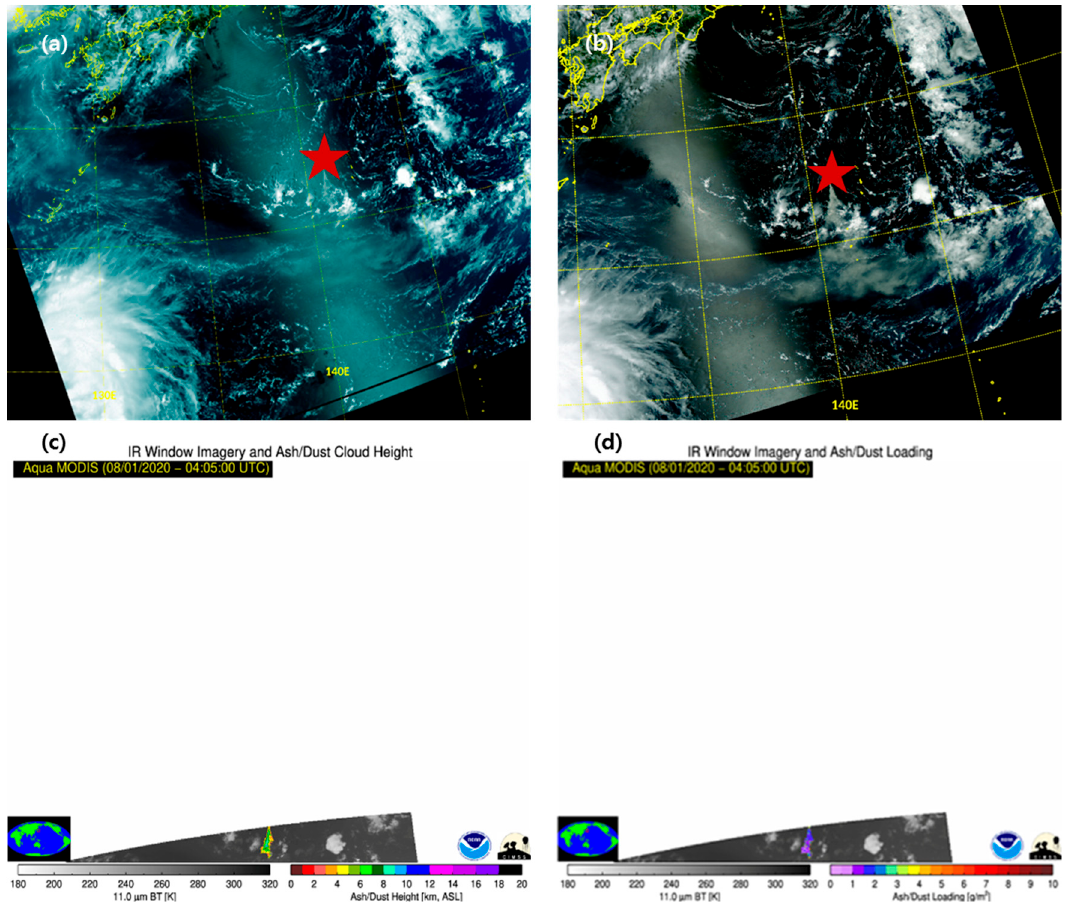
Figure 7. Images of low Earth orbit (LEO) satellites in the Nishinoshima area obtained on 1 August 2020. ( a ) Suomi- NPP/VIIRS True color RGB (03:38 UTC), ( b ) Aqua/MODIS (MODerate resolution Imaging Spectroradiometer) True color RGB (04:07 UTC), ( c ) Aqua/MODIS image of the ash/dust cloud height (04:05 UTC), ( d ) Aqua/MODIS image of ash/dust loading (04:05 UTC). The images can be accessed at https://volcano.ssec.wisc.edu/imagery/view/ (accessed on 10 February 2021, Space Science and Engineering Center at the University Wisconsin; NOAA (National Oceanic and Atmospheric Administration)/CIMSS (Cooperative Institute for Meteorological Satellite Studies)).